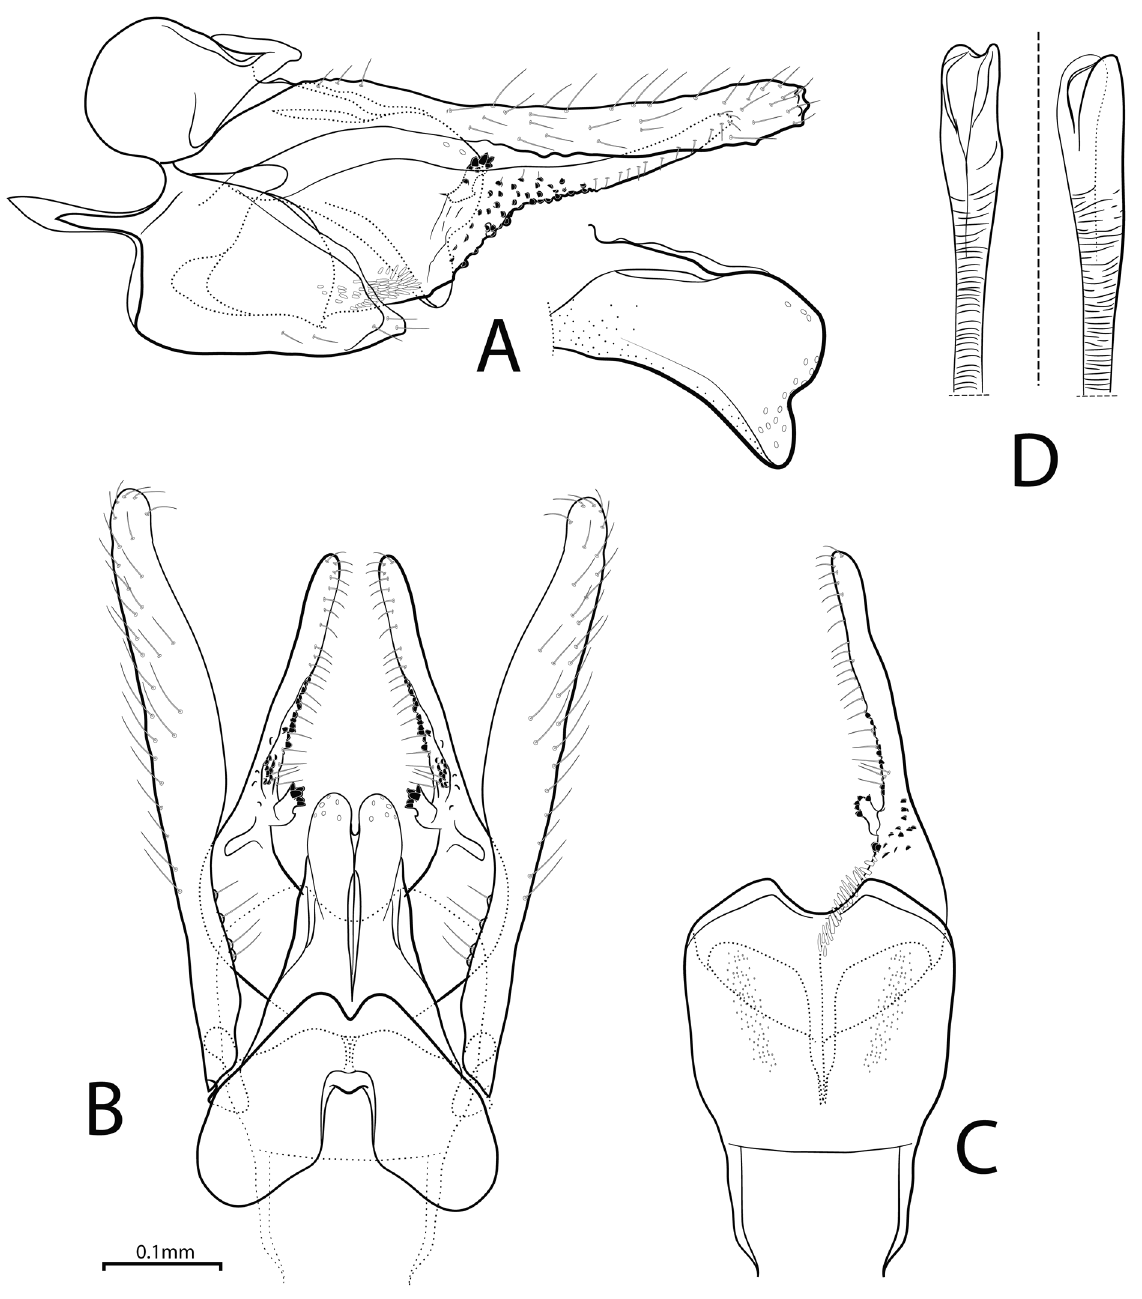
Fig. 8. Xiphocentron yine sp. nov., holotype, male genitalia (MUSM-ENT-0320567). A . Lateral view, with detail of paraproct. B . Dorsal view. C . Ventral view. D . Phallus, dorsal and lateral views,